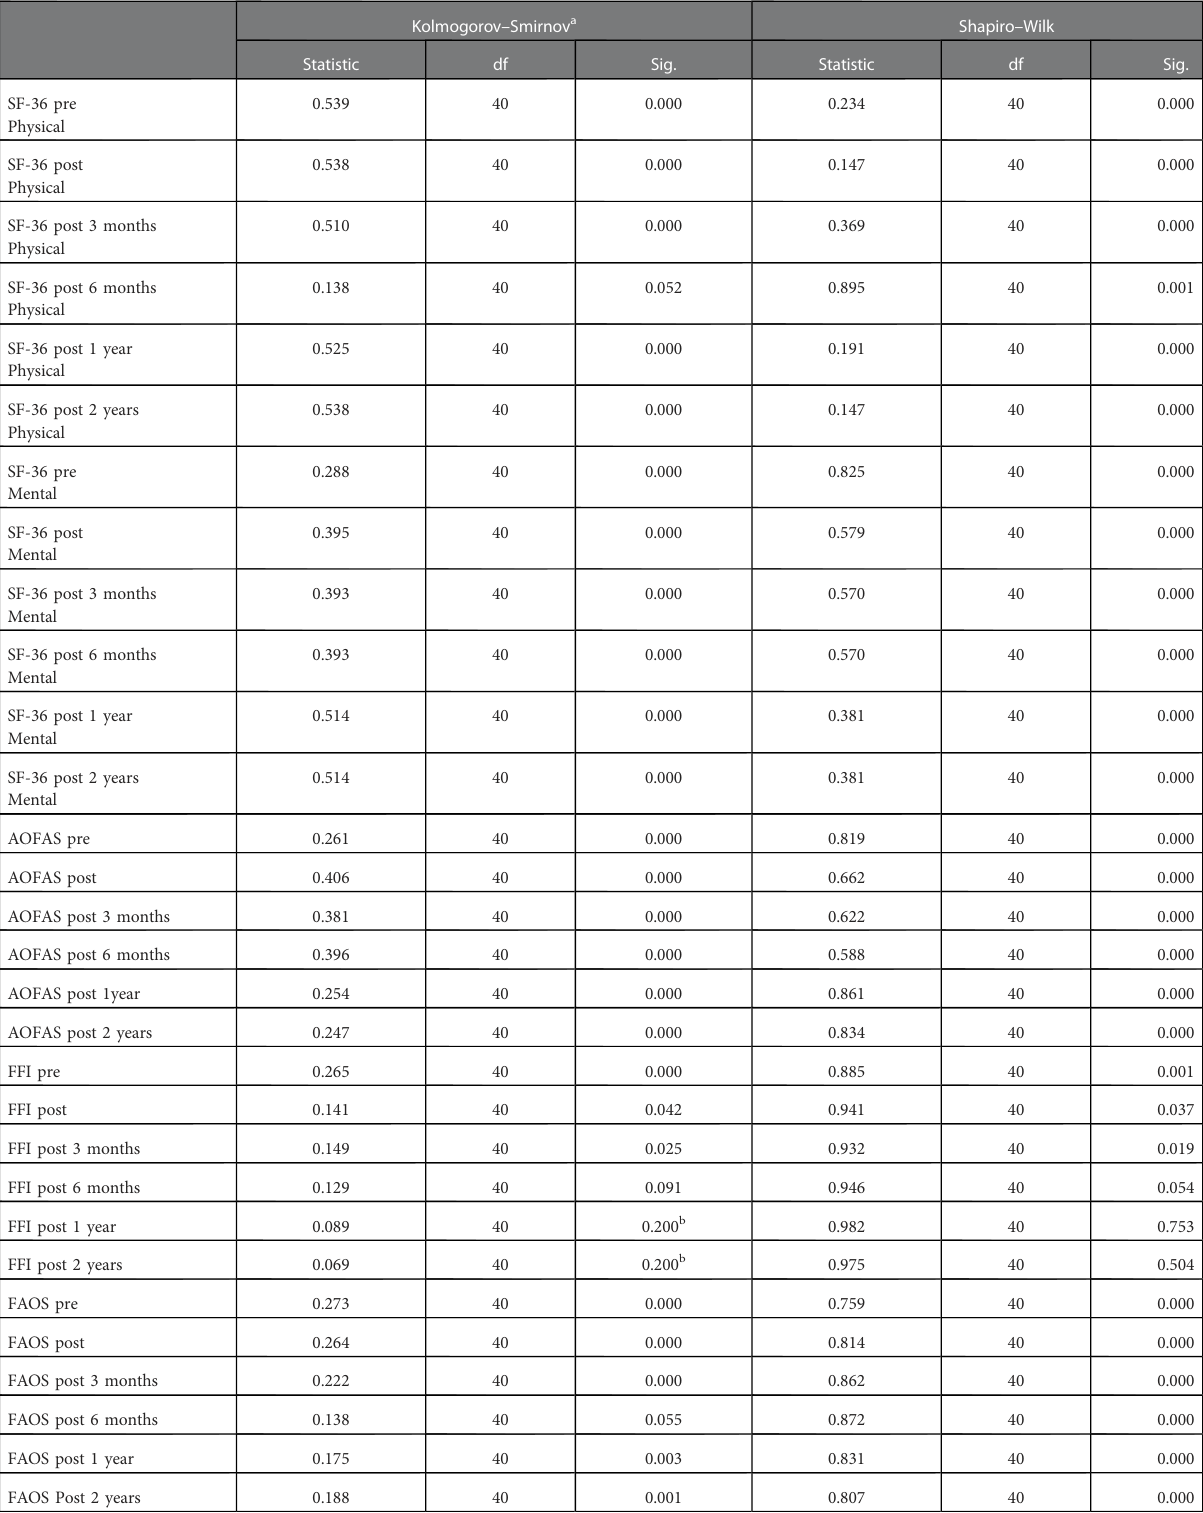
TABLE 1 Test of normality. Kolmogorov – Smirnov a Shapiro –